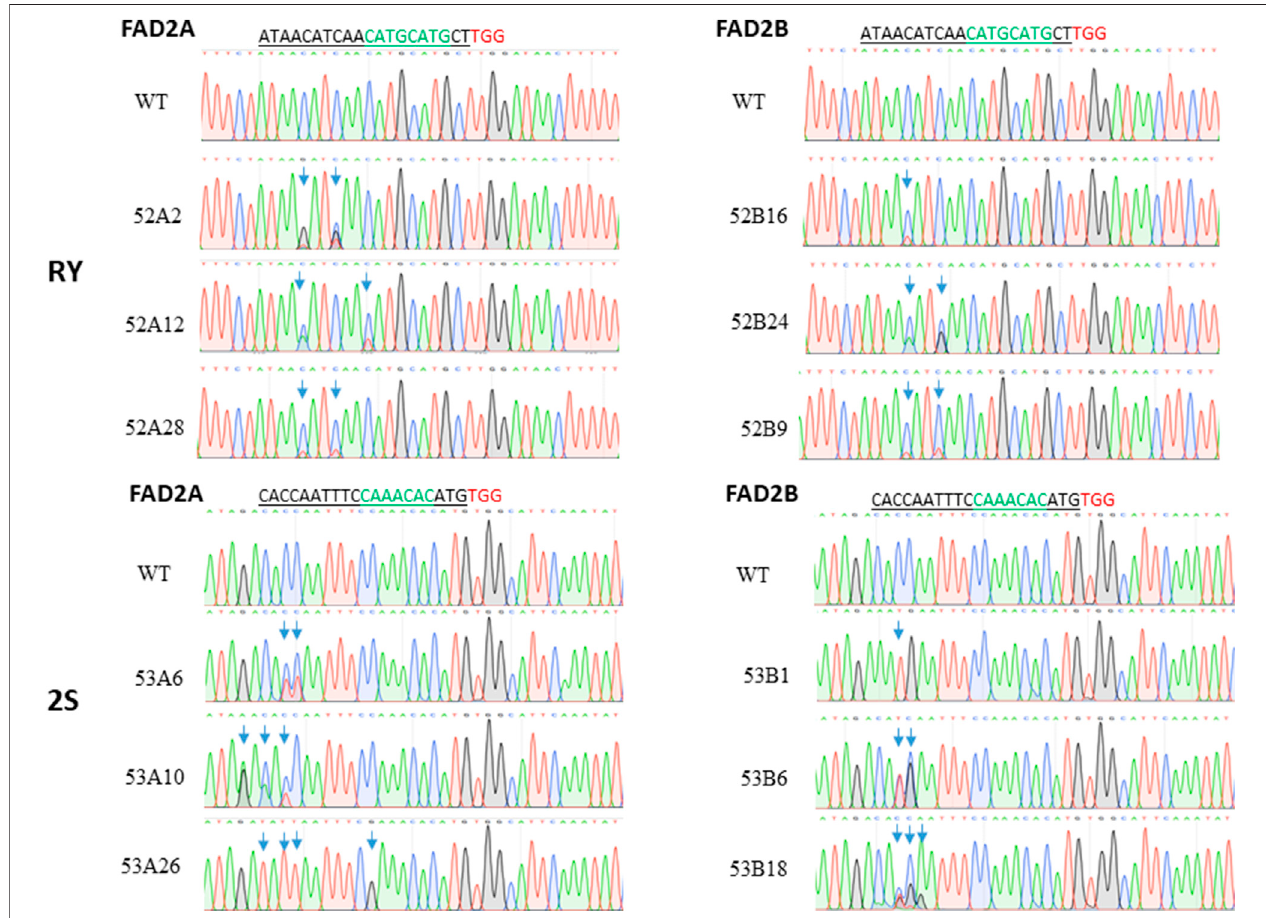
FIGURE2| BaseeditingatthetargetsRYand2S.TheredlettersrefertoPAM,thegreenlettersindicatedthetarget,underlinedlettersarethegRNAsequenceand the boxed area represents the observed mutation window.